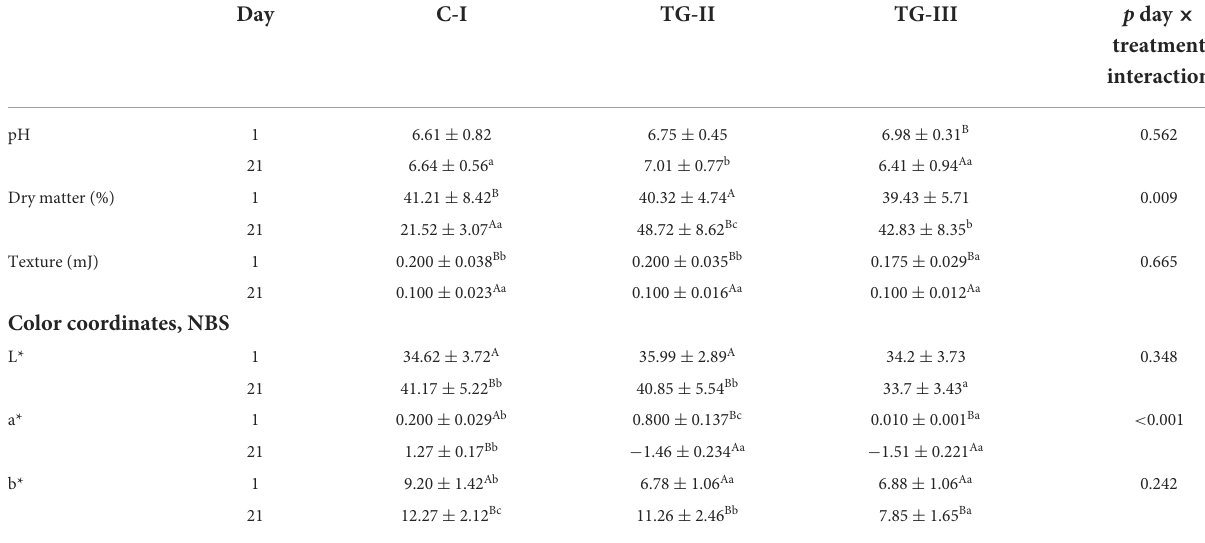
TABLE 3 The pH, dry matter and color coordinates of piglet feces. Day C-I TG-II TG-III p day ×